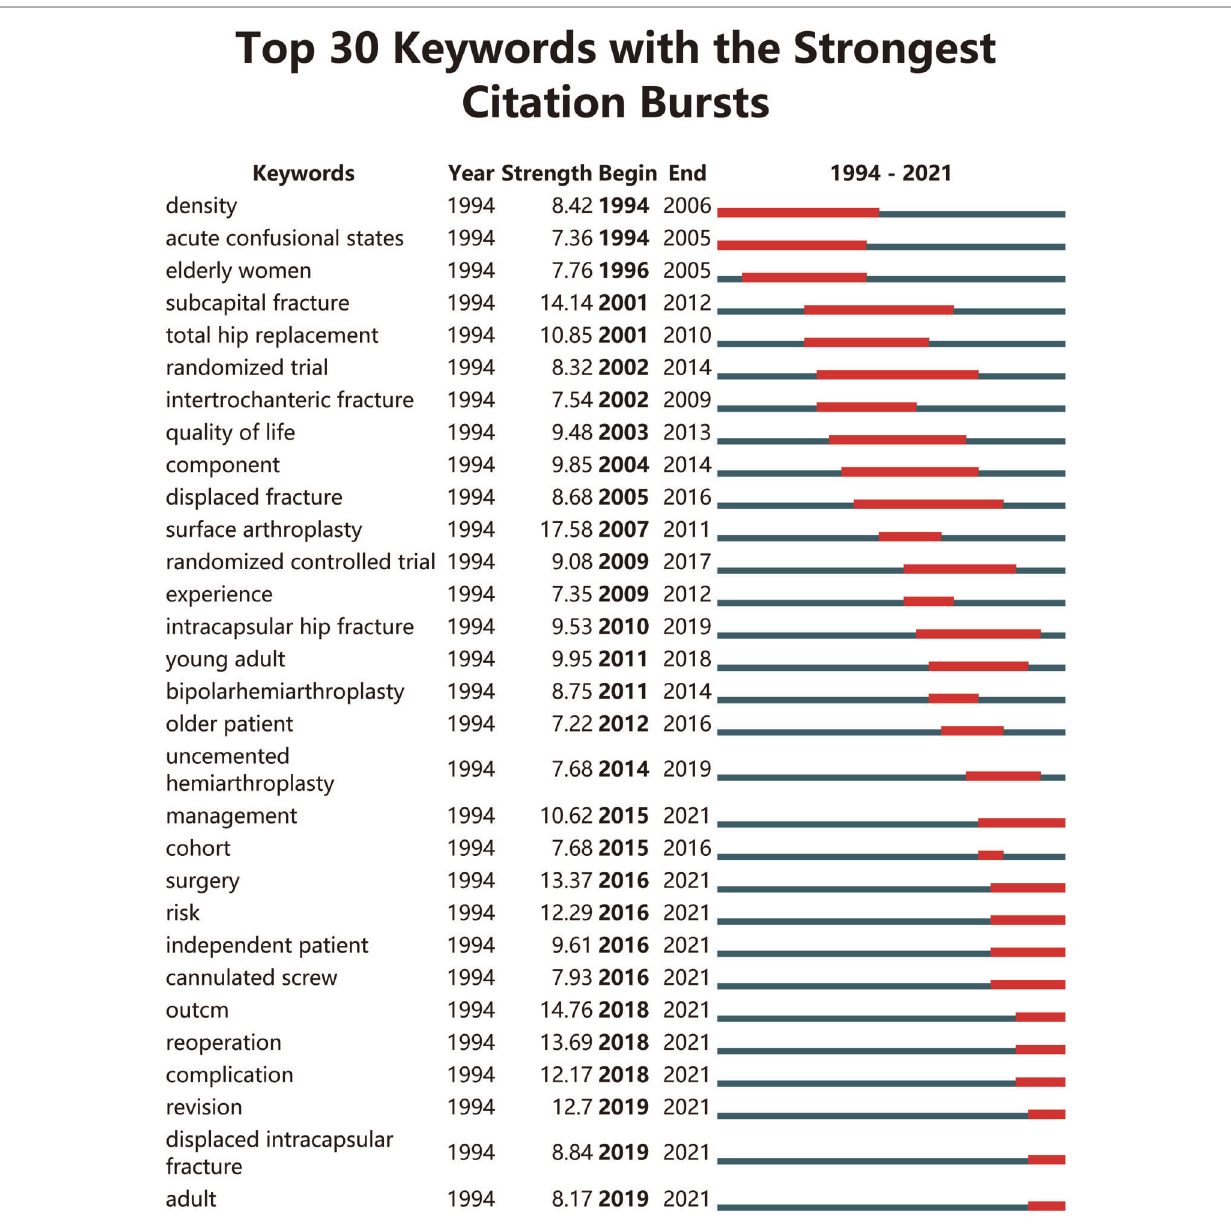
FIGURE 8 | The top 30 keywords with the strongest citation bursts from 1994 to 2021 (generated by